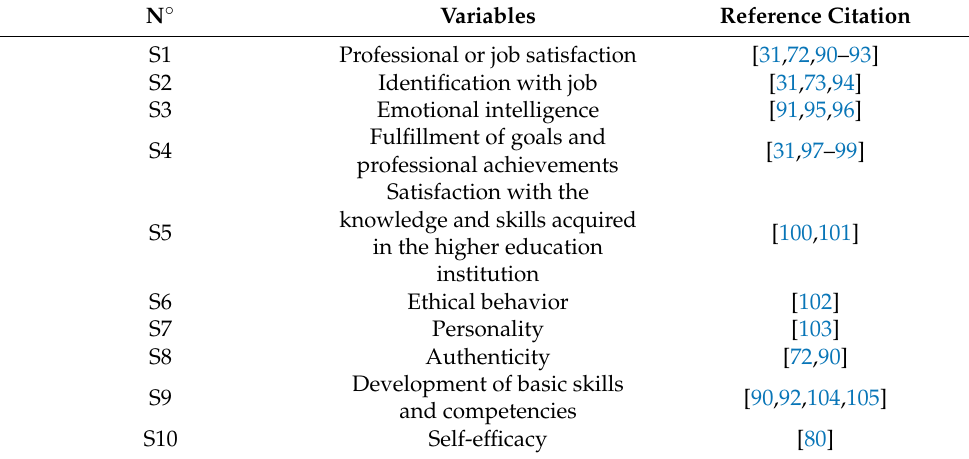
Table 3. SCS Variables.